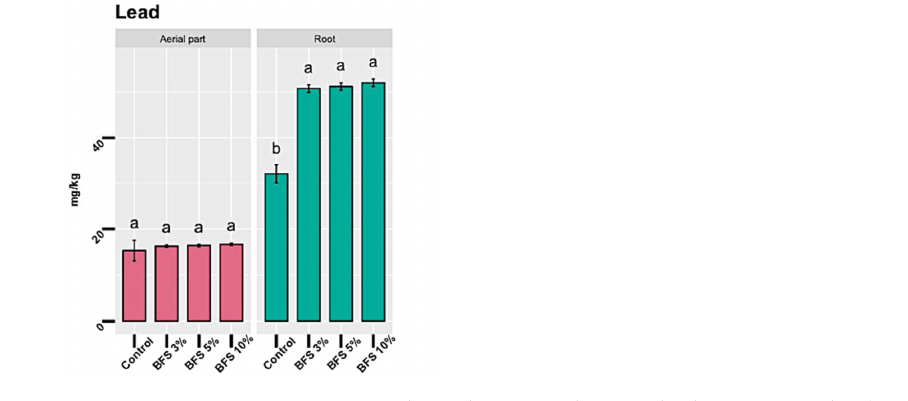
Figure 7. PTE content in soil with the amendment of Blast Furnace Slag (BFS) and Activated Carbon (AC).